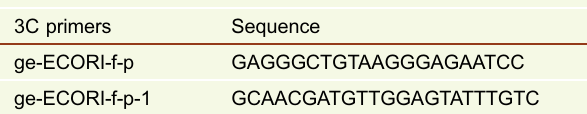
c Figure 5. The conservation of GE in various human